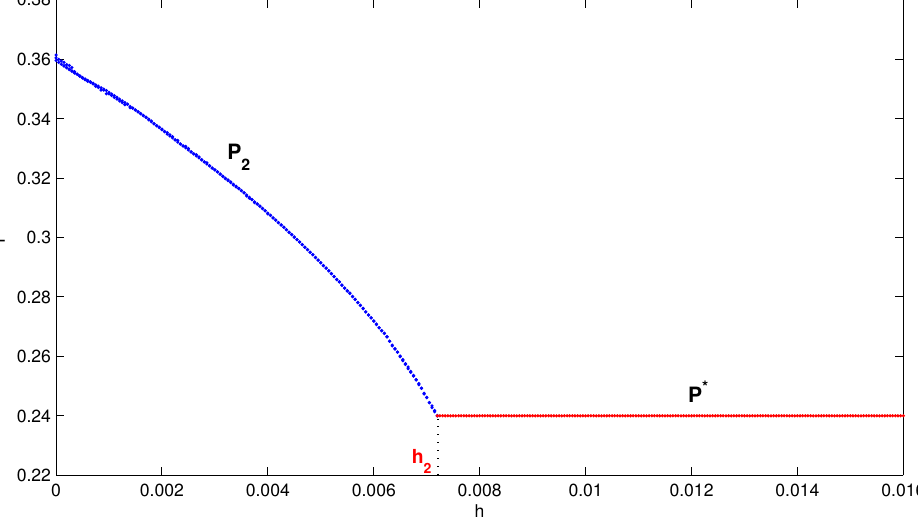
Figure 1. The forward bifurcation diagram from P ∗ to P 1 versus u for Equation (3). The line with P 1 indicates the curve of the predator with coexistent equilibrium E 1 , and the line with P ∗ indicates the curve of the predator with coexistent equilibrium E ∗